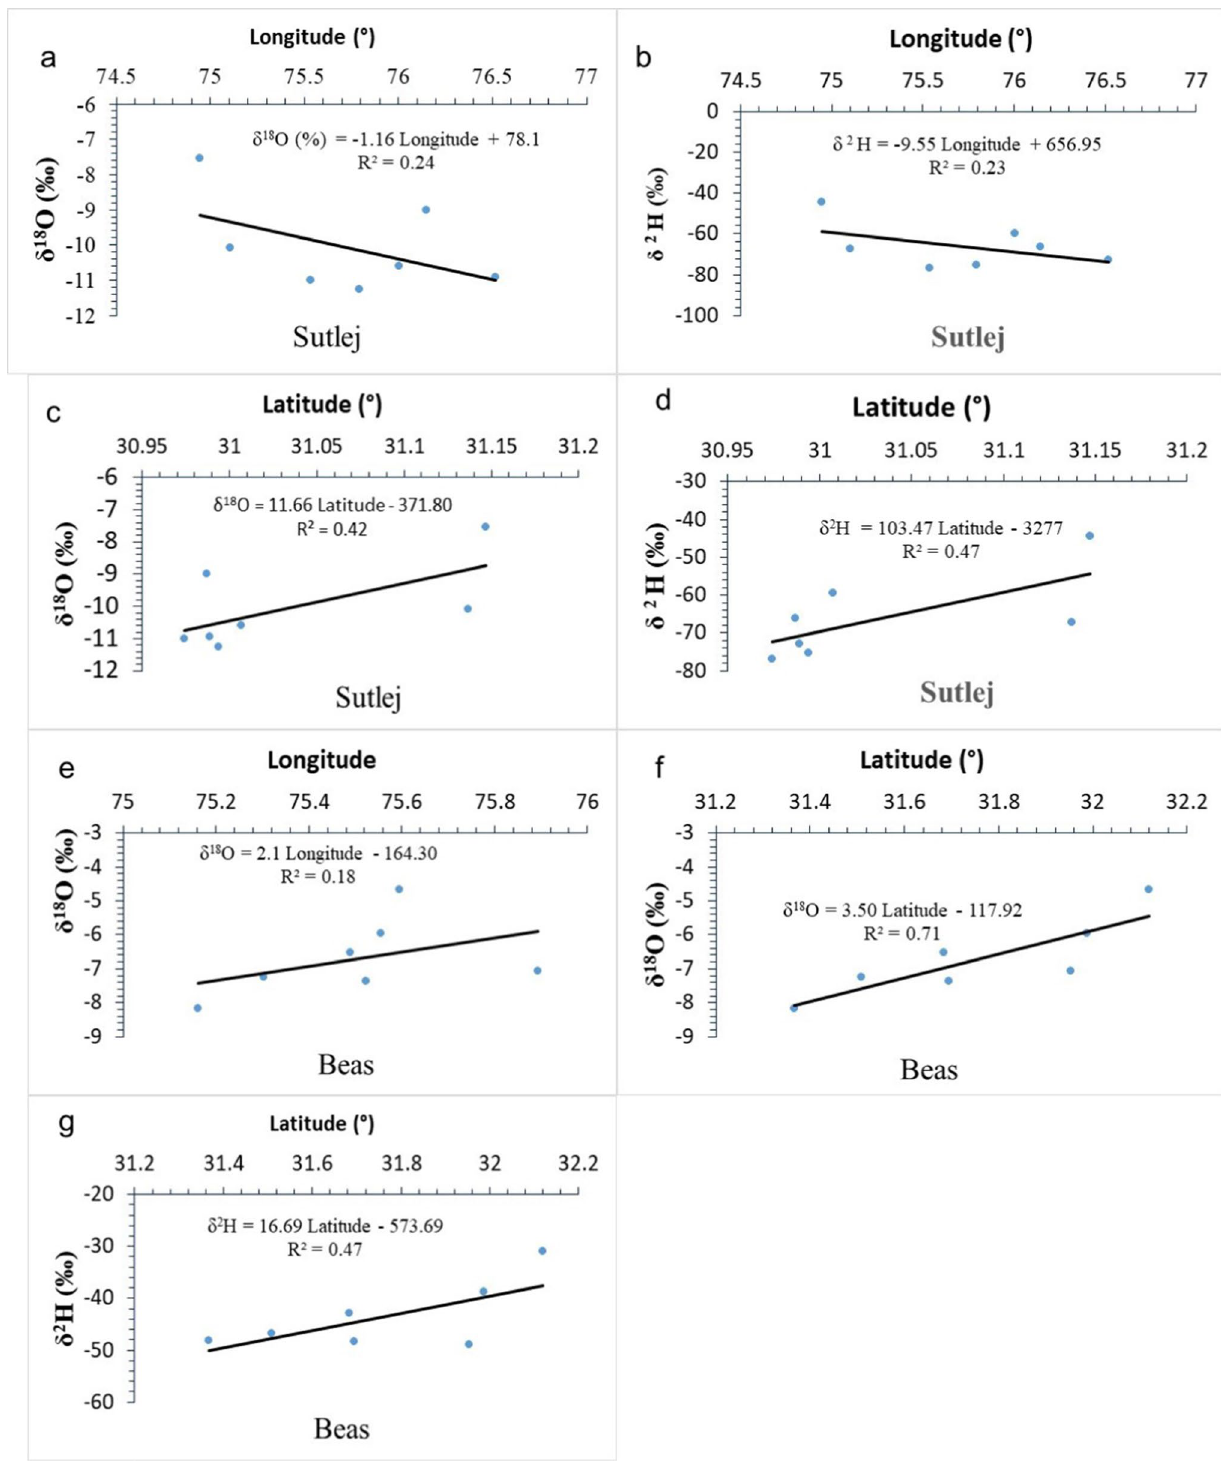
Fig. 11 The linear regression relationships are shown in a δ 18 O and longitude for River Sutlej, b δ 2 H and longitude for River Sutlej, c δ 18 O and latitude for River Sutlej, and d δ 2 H and latitude for River Sutlej. The linear regression relationships are shown in e δ 18 O and longitude for River Beas, f δ 18 O and latitude for River Beas, and g δ 2 H and latitude for River